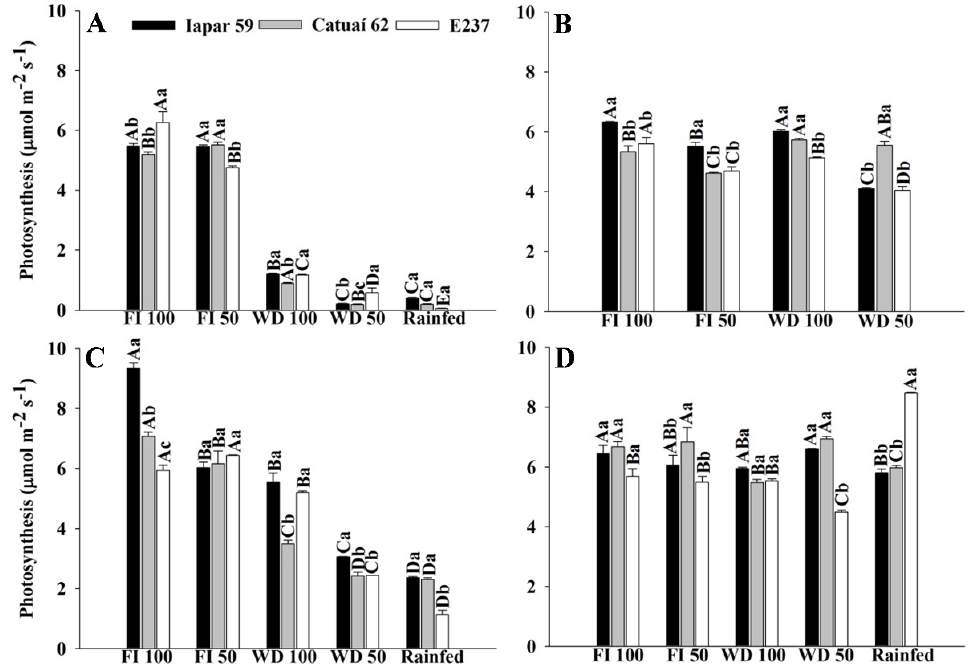
Figure 6. Photosynthetic rates of coffee leaves under water stress ( A , C) and after irrigation ( B , D ), in 2019 ( A , B ) and 2020 ( C , D ), of three arabica coffee genotypes (Iapar 59, Catuaí 62 and E237) under five water regimes (FI 100, FI 50, WD 100, WD 50 and rainfed). Capital letters compare the water regimes for each cultivar and lowercase letters compare the cultivars of each water regime. Means followed by the same letter do not differ according to the Tukey test at 5% probability. FI 100 and 50 (full irrigation with 100% and 50% replacement of evapotranspiration); WD 100 and 50 (water deficit with the suspension of irrigation from June to September, with replacement of 100% and 50% of evapotranspiration, respectively); rainfed (without irrigation).